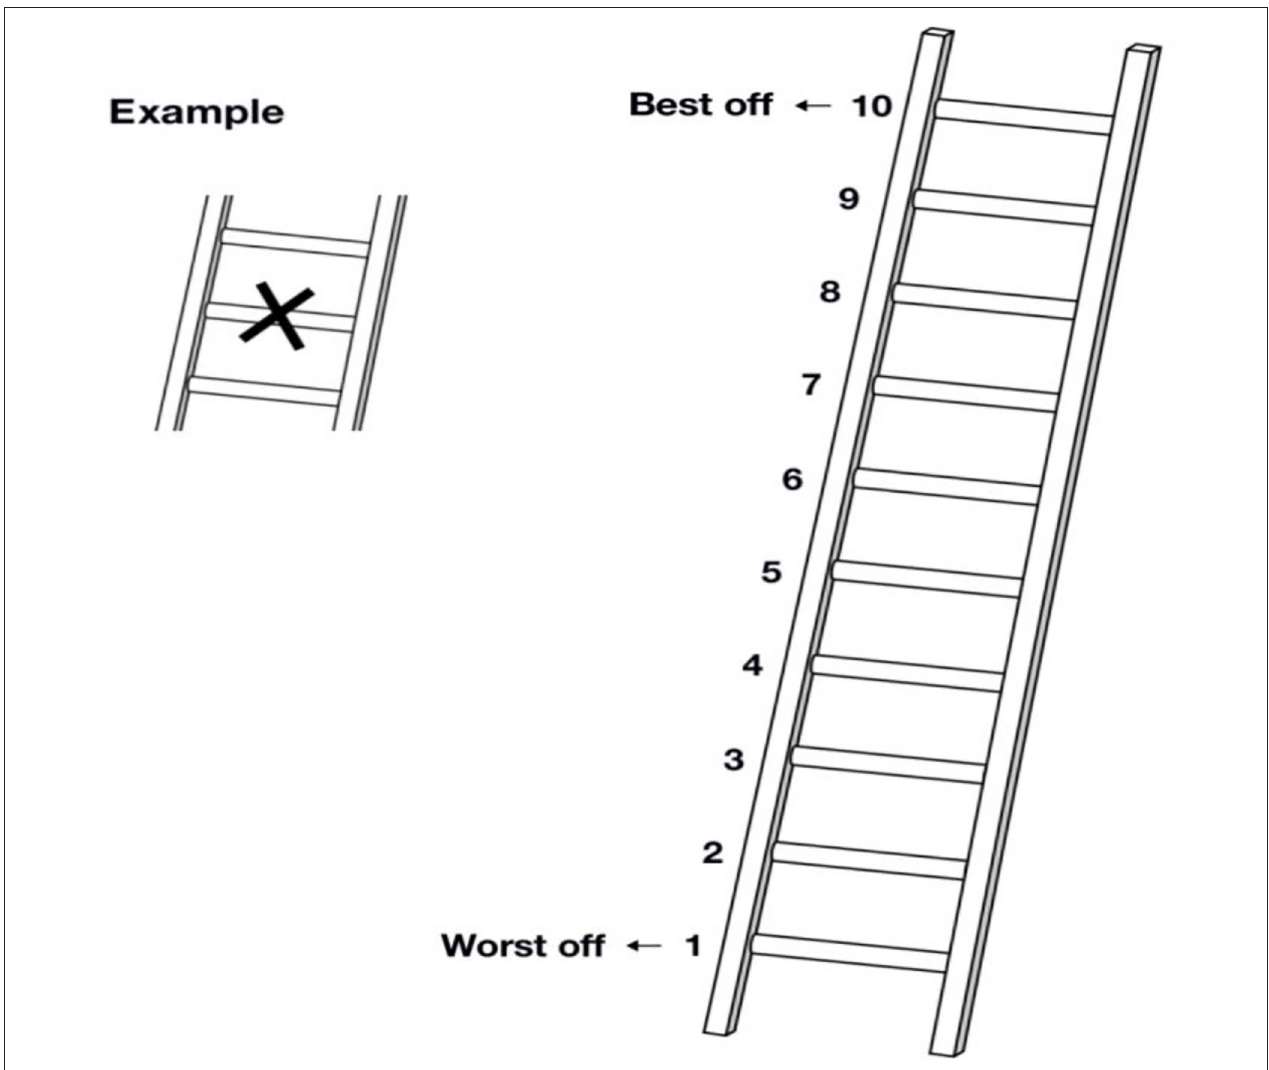
FIGURE 2 | The subjective social status was measured using the MacArthur scale. (1) Here is a ladder. Think of this ladder representing where people stand in Zhejiang Province. At the top of the ladder are the people who are the best off—those who have the most money, the most education, and the most respected jobs. At the bottom are the people who are the worst off—who have the least money, the least education, and the least respected jobs or no jobs. The higher up you are on this ladder, the closer you are to the people at the very top, and the lower you are, the closer you are to the people at the very bottom. If you consider your current situation and compare it with all other people in Zhejiang Province, where would you place yourself on this ladder? Please mark an X on the rung that best represent your situation. (2) Here is another ladder. Think of this ladder as representing where people stand in the people around them. At the top of the ladder are the people who are the best off—those who have the most money, most education, and best jobs. At the bottom are the people who are the worst off—those who have the least money, least education, and worst jobs or no job. If you consider your current situation and compare it with all the people around you, where would you place yourself on this ladder? Please mark an X on the rung that best represent your